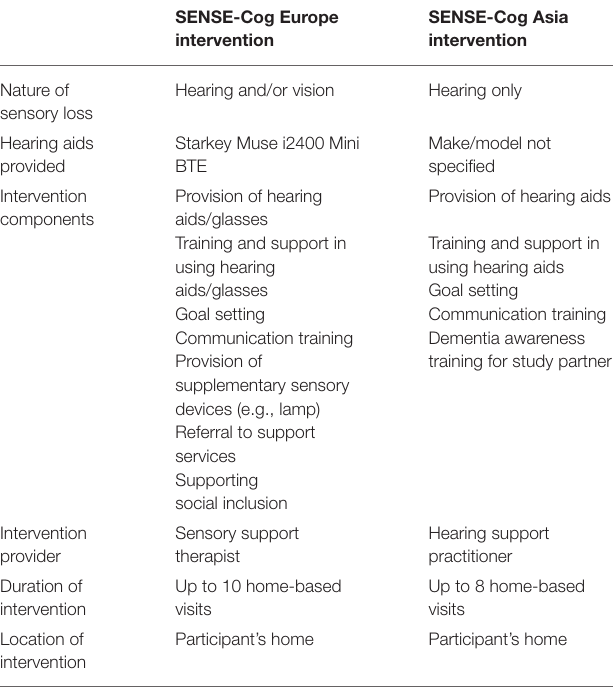
TABLE 1 | Similarities and differences between the SENSE-Cog Europe and Asia interventions. SENSE-Cog Europe